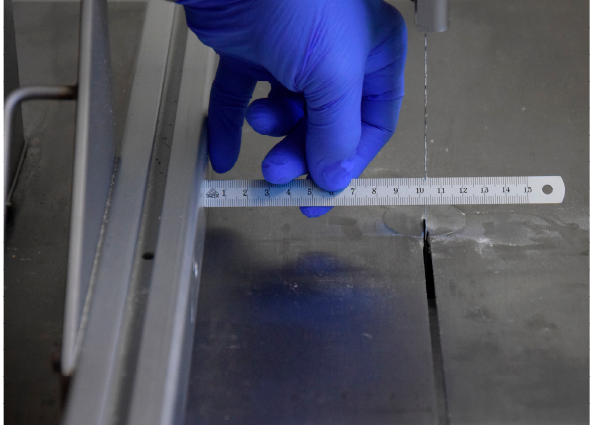
Figure A1. All osteotomies were set using a customised cutting template ensuring consistent course of fracture lines.